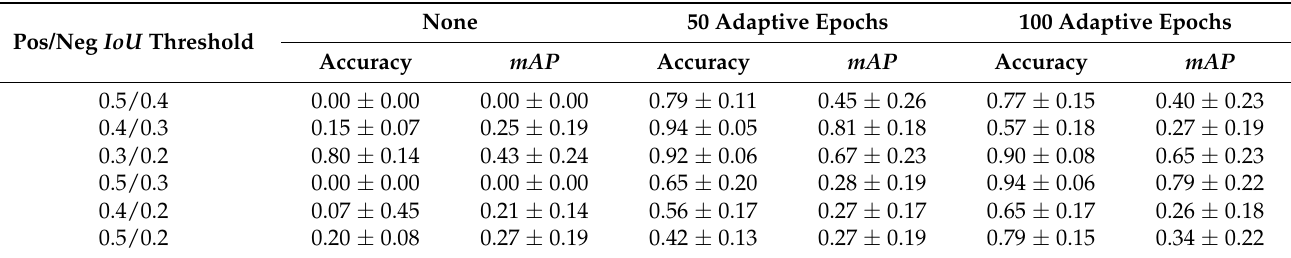
Table 4. Detection accuracy and map of the studied models as a function of the threshold and the number of adaptive epochs. Each value is expressed as mean and standard